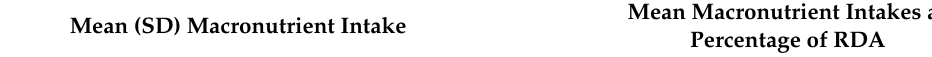
Table 7. Comparison of mean macronutrient intake with percentage of recommended dietary allowance (RDA) during